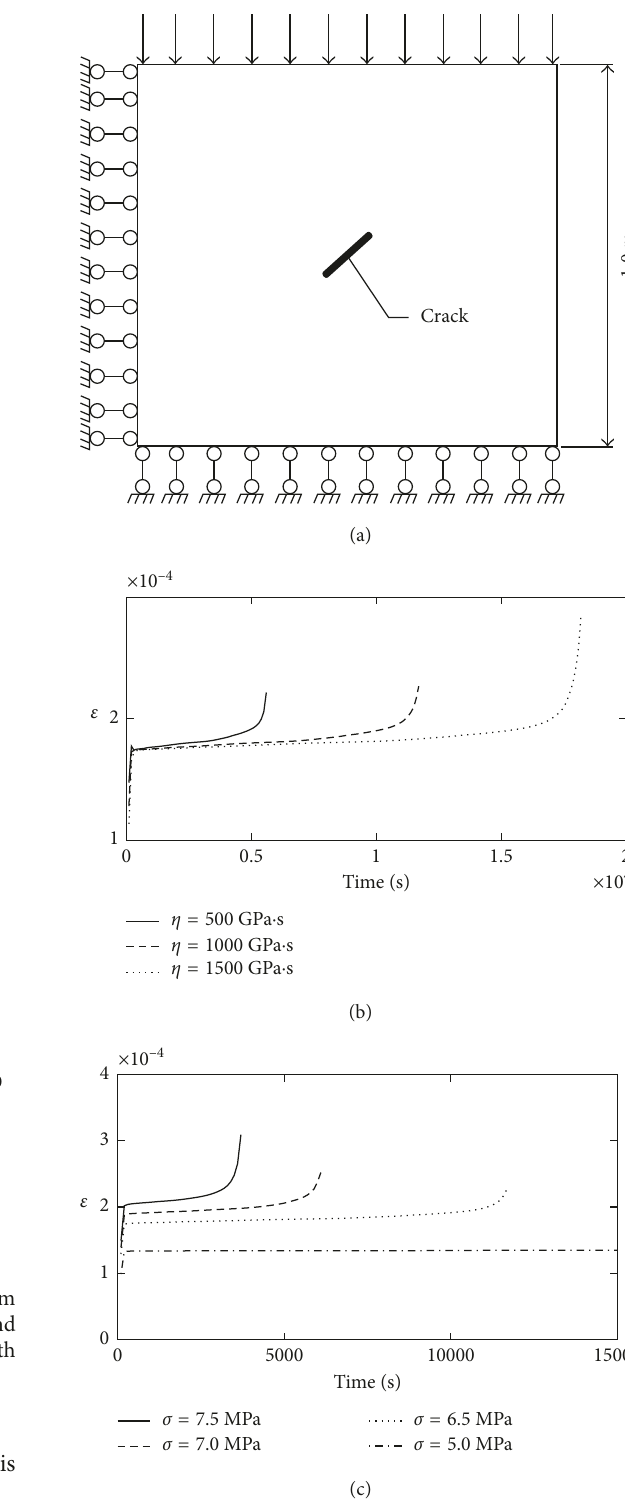
Figure 6: Simulation of creep fracture: (a) simulation specimen; (b) effect of viscosity on creep; (c) effect of external stress on